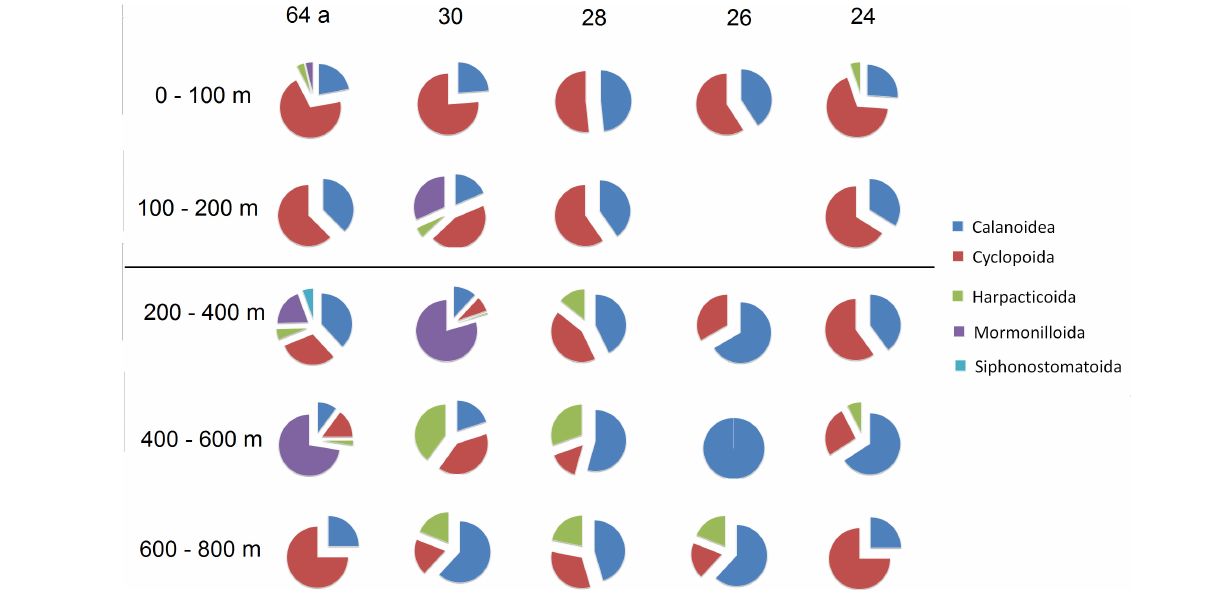
FIGURE 4 | Pie charts to illustrate the distribution of orders of the subclass Copepoda in five stations and different depth strata in the oligotrophic water of the south Pacific subtropical gyre during the CIMAR-21 cruise (October–November